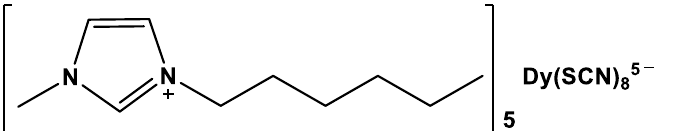
Figure 12. Magnetic ionic liquid with 1-hexyl-3-methylimidazolium as cation and a dysprosium complex as anion.